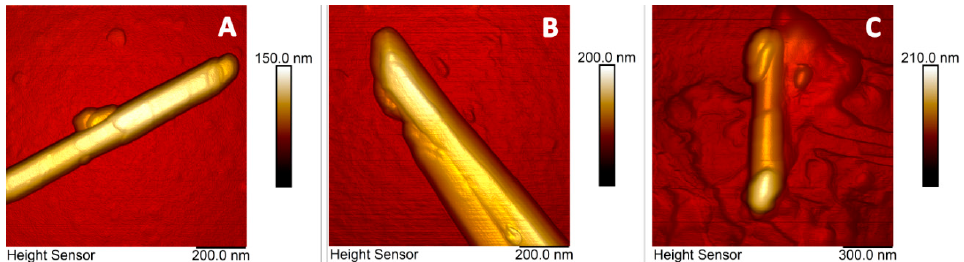
Figure 3. AFM images of pristine ( A ), Mg-( B ) and Mg-DNA (C) -modified halloysite nanotubes. Ultrasonicated DNA binding to halloysite was also confirmed by changes in halloysite ζ - potential (Table 1) and thermogravimetric data (Table 2). Based on the TGA data analysis, dATPNa was not loaded into the nanotubes (neither in the presence nor in the absence of MgCl 2 ). Additionally, the degradation steps of MgCl 2 were not detected in the hybrid systems (HNT-DNA-MgCl 2 and HNT-dATPNa-MgCl 2 ). Therefore, the amounts of MgCl 2 in the loaded nanotubes were negligible. Table 2. (Poly)nucleotide content in halloysite nanotubes according to thermogravimetric analysis. Sample